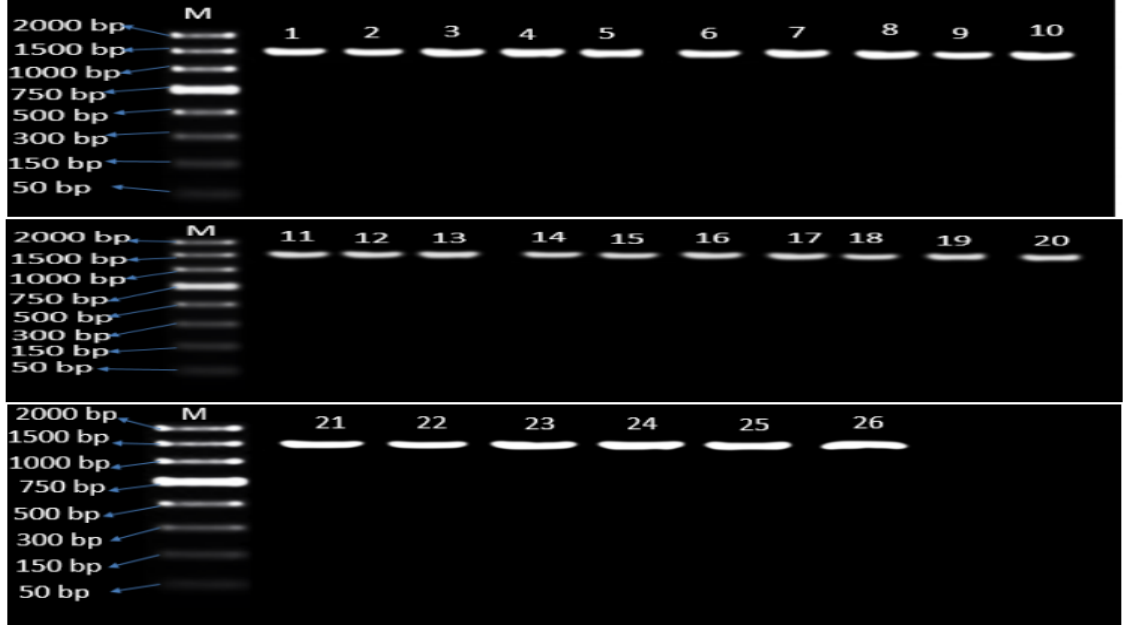
Figure 4. Full length16S rRNA gene (1500bp) of Bacillus isolates amplified with universal primers. The amplicon was resolved on 1% agrose gel. M, DNA ladder lanes 1-26: amplified products of full length 16S r RNA gene.